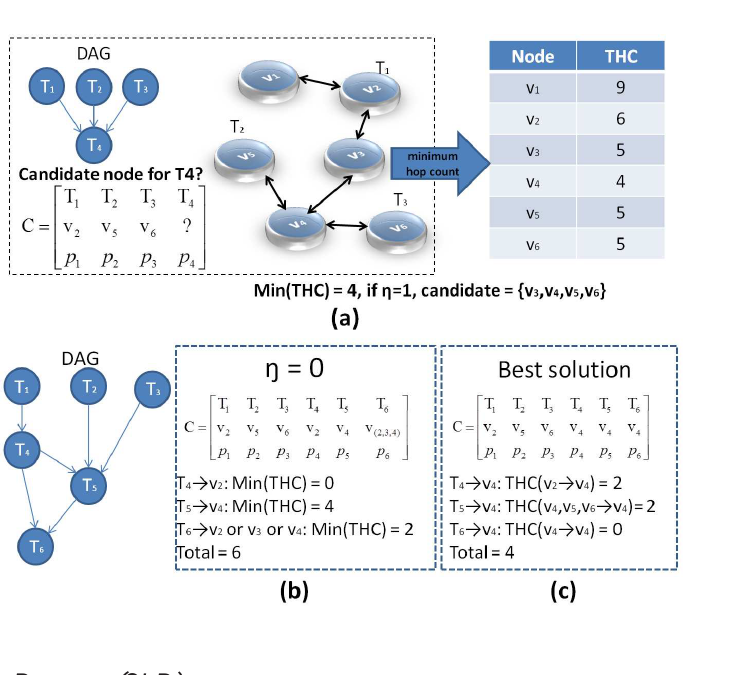
Figure 4. Minimum Hop Count candidate selection.